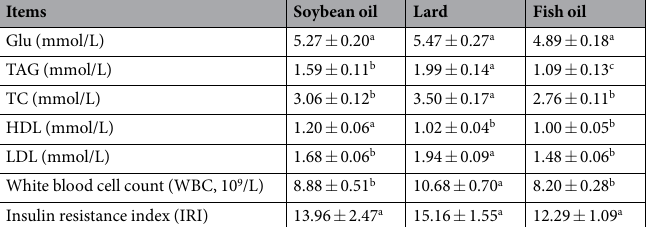
Table 2. Blood parameters of rats fed with soybean oil, lard or fish oil diets (means ± standard errors, n = 11).